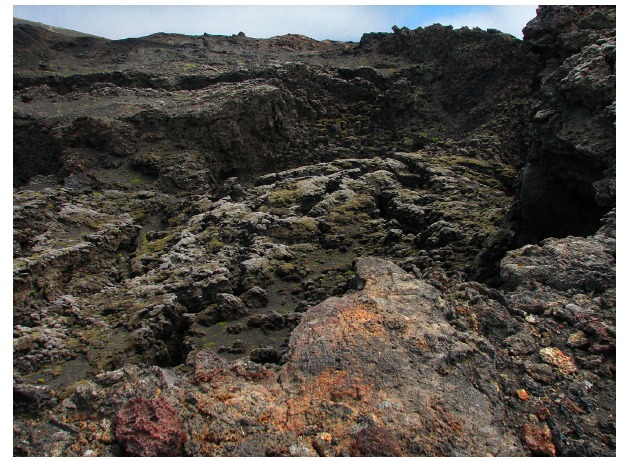
Figure 5. Moss carpet, mostly made up of Racomitrium lanugi- nosum , in the bottom of Surtungur crater, the largest crater on Surt- sey. Photo: GVI, 9 July